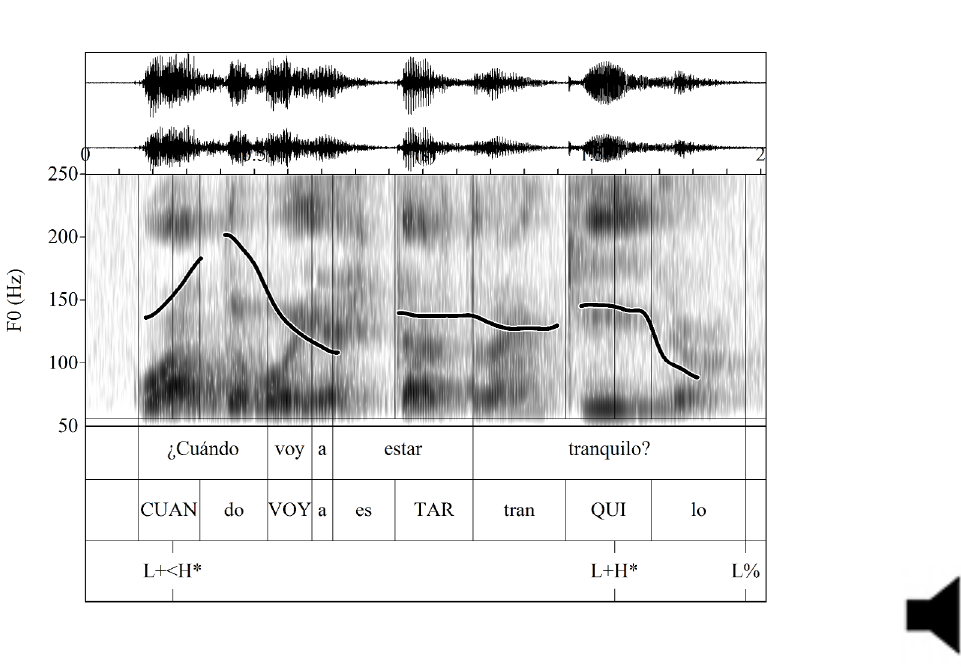
Figure 24 (Participant 26): Waveform and F0 trace for the rhetorical wh- question ¿ Cuándo voy a estar tanquilo? ‘When am I going to be left alone?’ produced as L+<H* (1 st prenuclear position), deaccenting (2 nd and 3 rd prenuclear positions) and as L+H* L% (nuclear configuration).